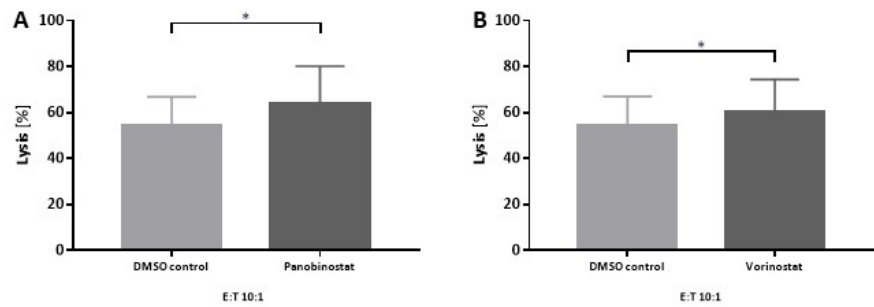
Figure 3. Lysis of SW982 cells by NY-ESO-1-specific T cells after 48 h pretreatment with panobinostat ( A ) or vorinostat ( B ). An effector (NY-ESO-1-specific T cells) to target (SW982 cells) ratio of 10:1 was used. DMSO pretreated SW982 cells served as solvent control. Data analyzed contain three individual experiments with three replicates. Statistical significance was calculated using a paired two-way student t-test. * p < 0.05.